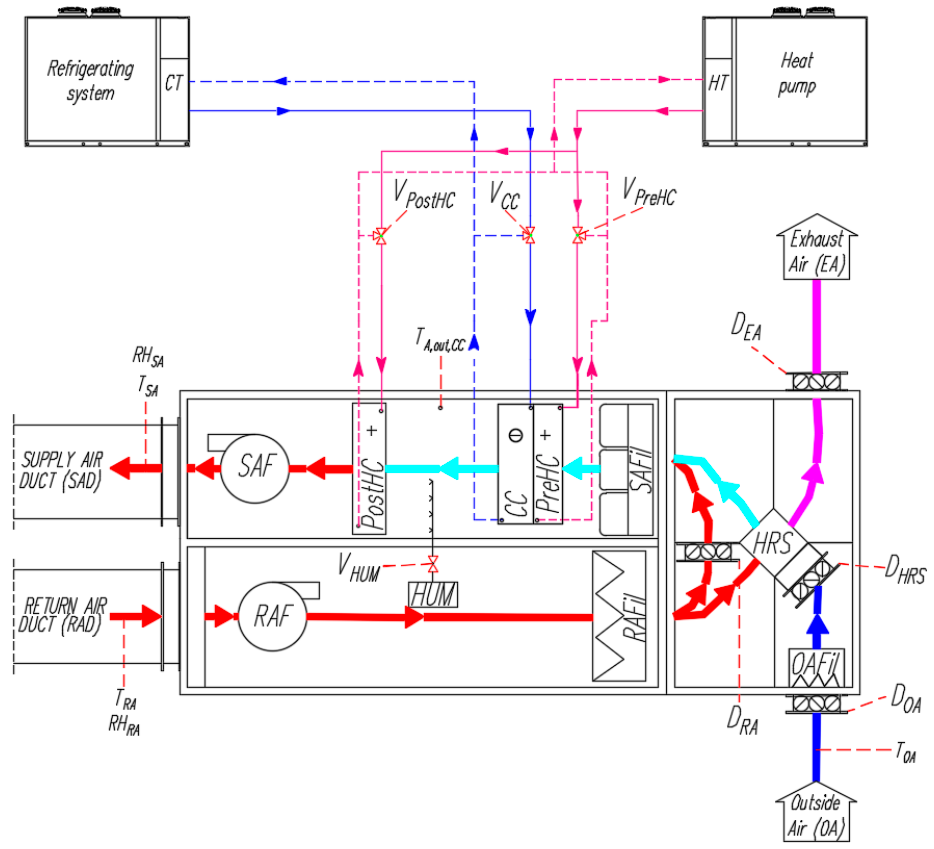
Figure 2. Schematic representation of the air-handling unit (AHU) serving the integrated test room.